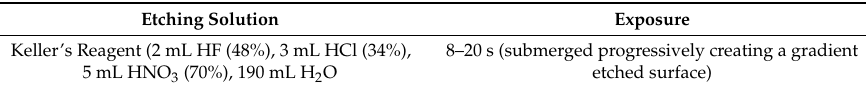
Table 5. Etching solution and exposure